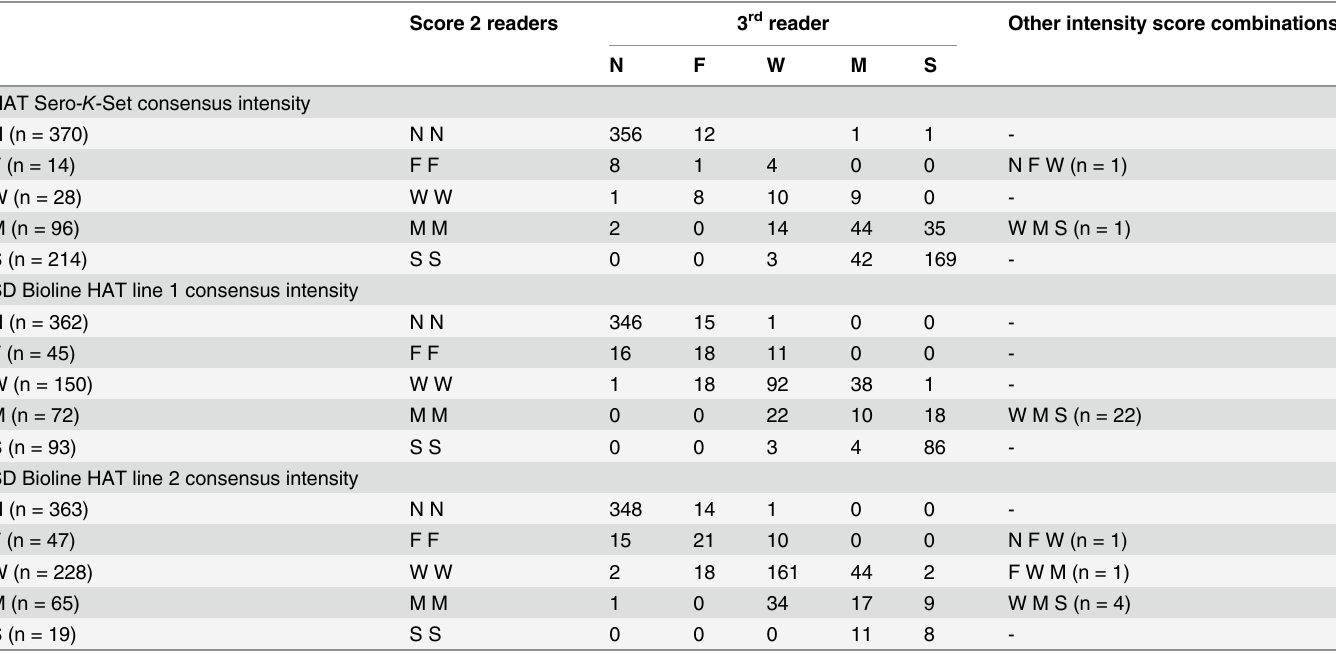
Table 1. Consensus intensity and intensity scores given by 3 readers to the test lines in HAT Sero- K -Set and SD Bioline HAT (line 1 and 2).